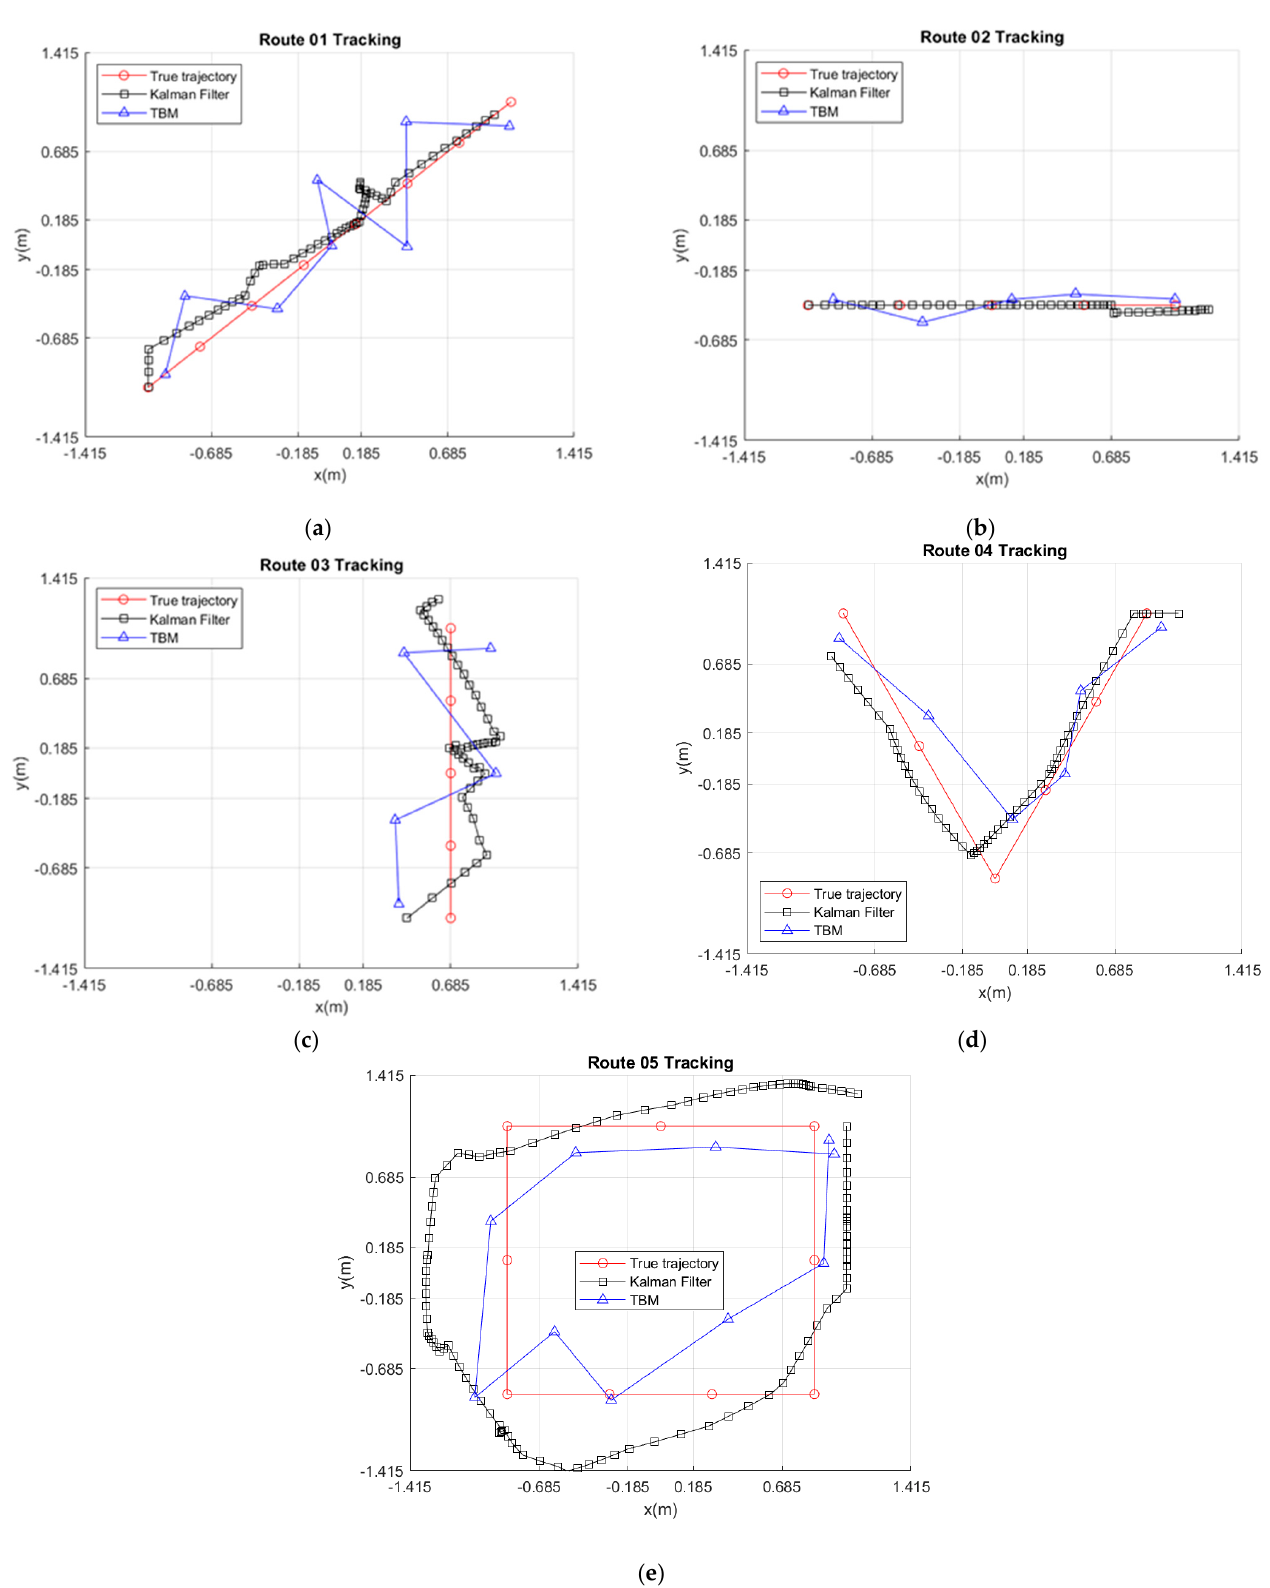
Figure 9. Typical examples of tracking results with Kalman filter and TBM: ( a ) Route 01, ( b ) Route 02, ( c ) Route 03, ( d ) Route 04, and ( e ) Route 05.